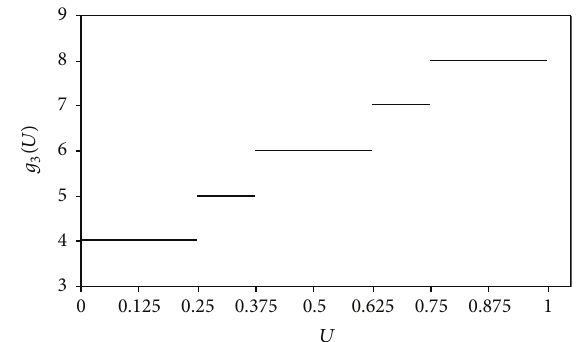
Figure4:Functionusedtosimulaterouteofvehicleenteringatnode